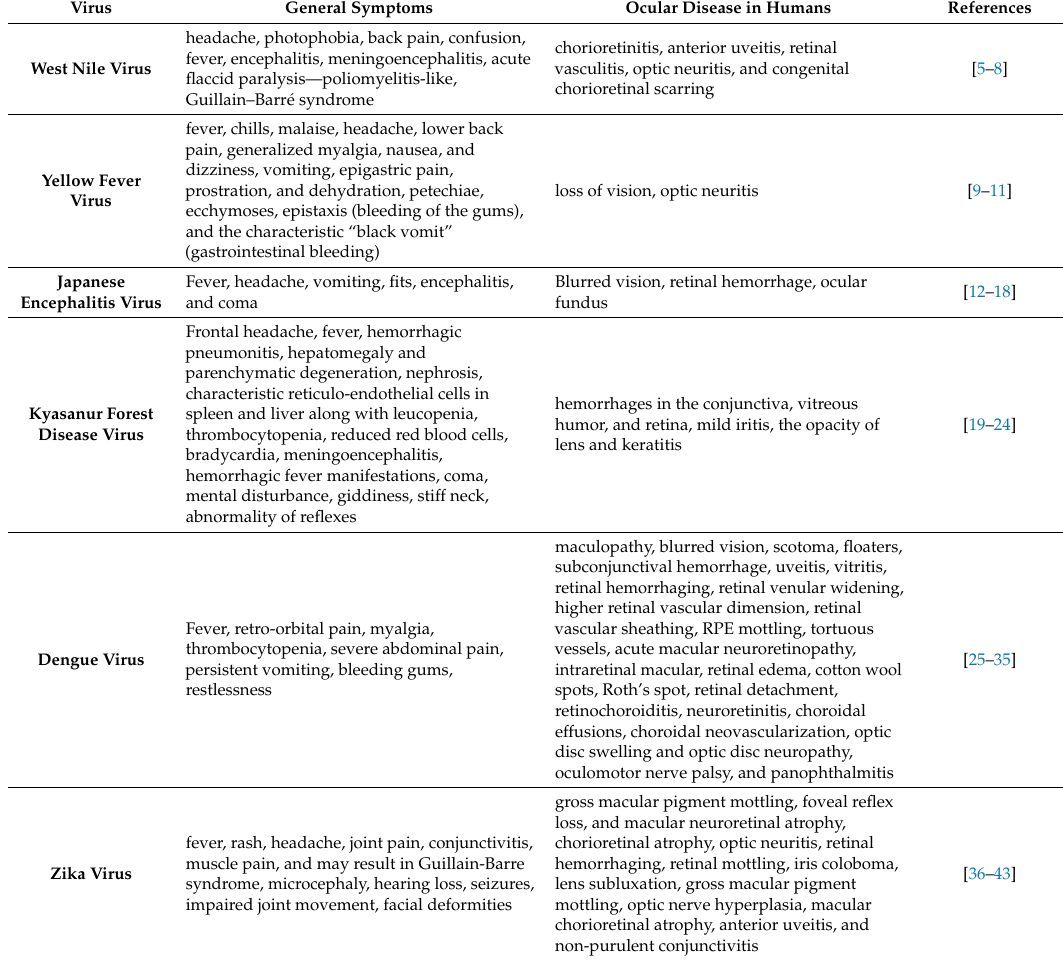
Table 2. Flaviviruses known to cause ocular disease in humans and their